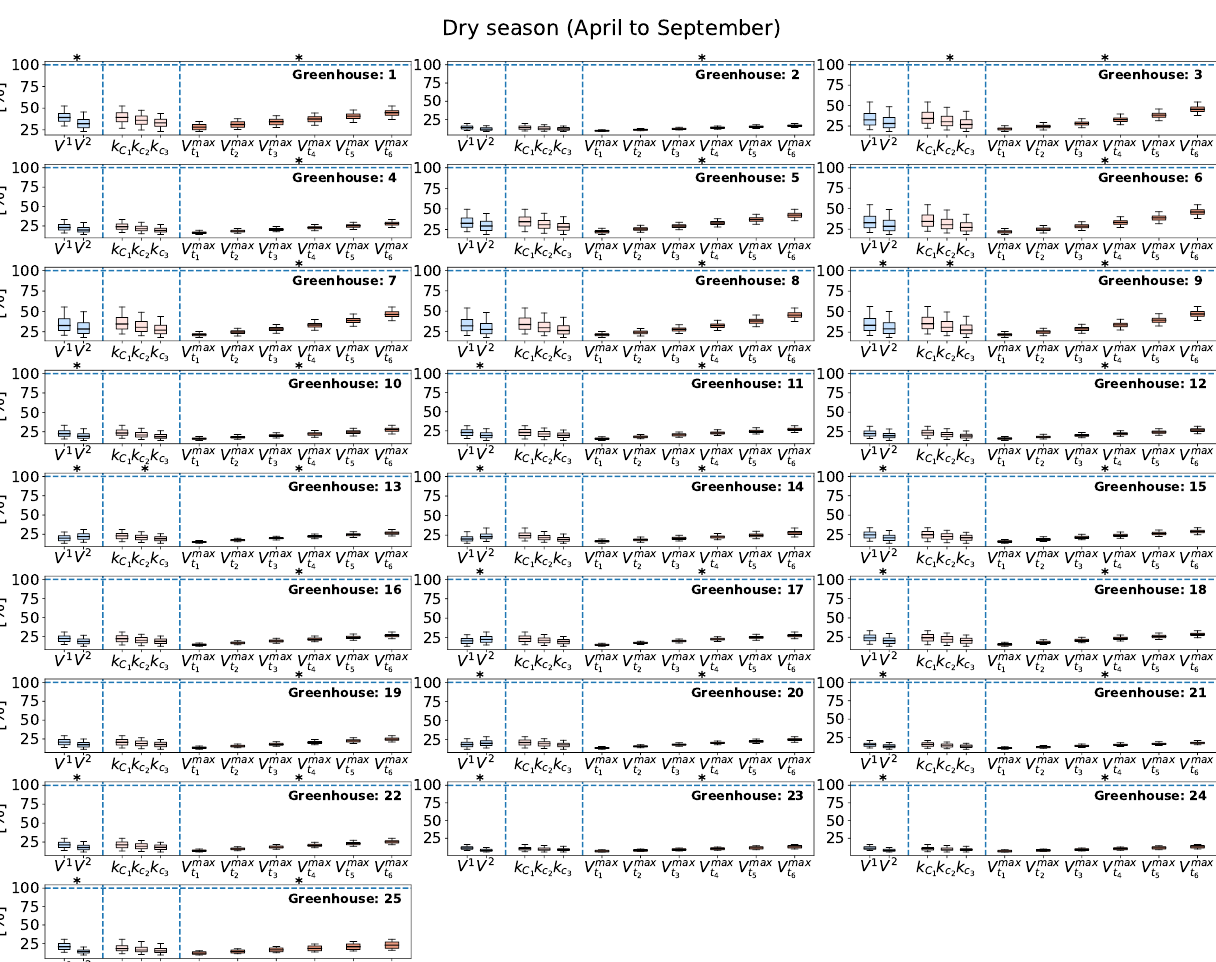
Figure 10. Same as Figure 9 but for the dry season (April to